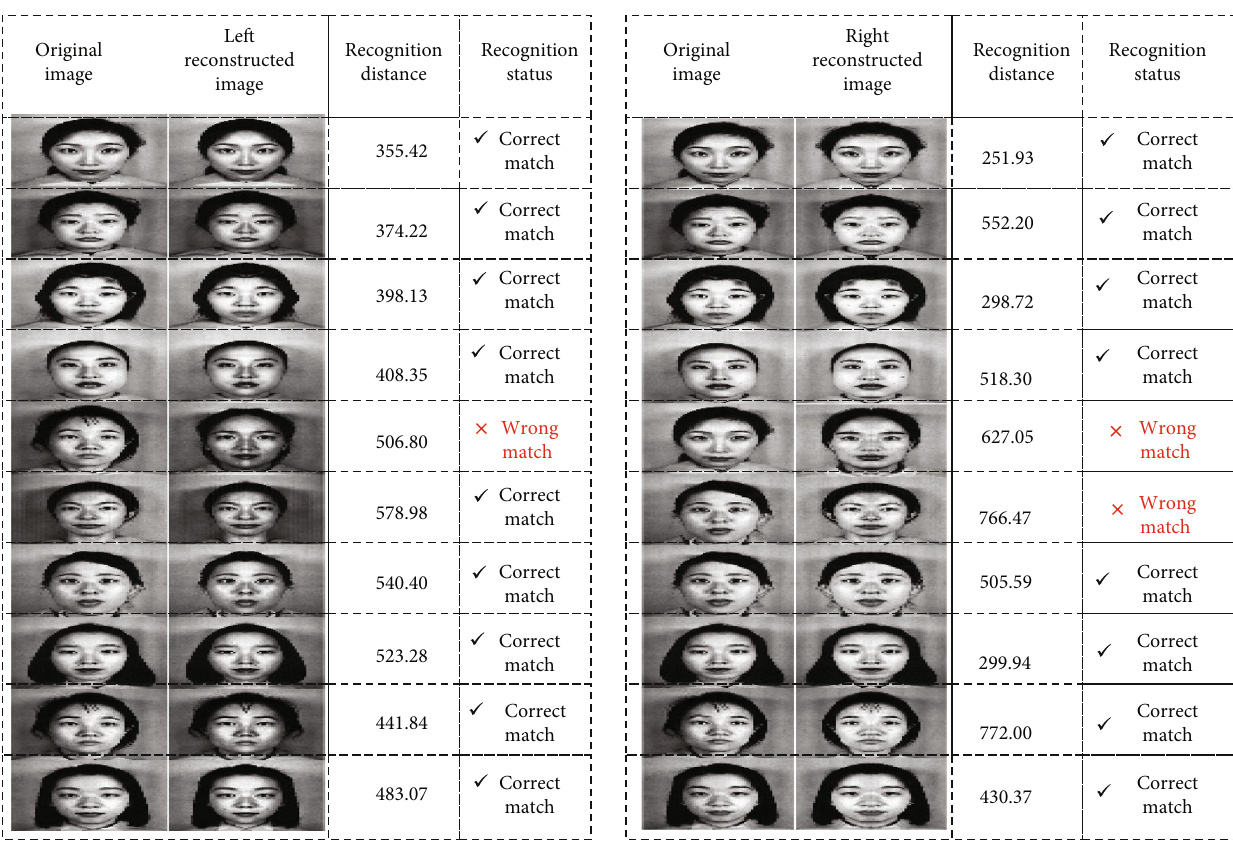
Figure 6: Recognition of the reconstructed images